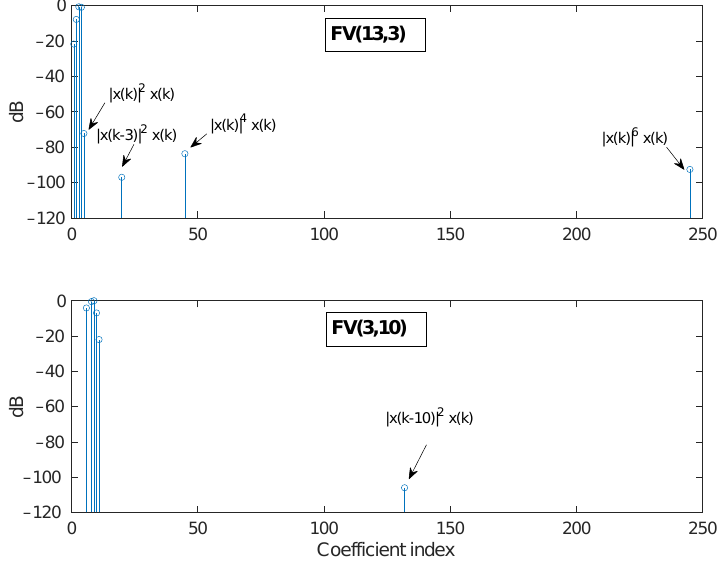
Figure 2. Normalized coefficients. Upper plot: Sub-optimal sparse model identified from the FV(13,3) model. Lower plot: New coefficients of the FV(3,10) structure and incorporated to the upgraded model. Average output level: 19